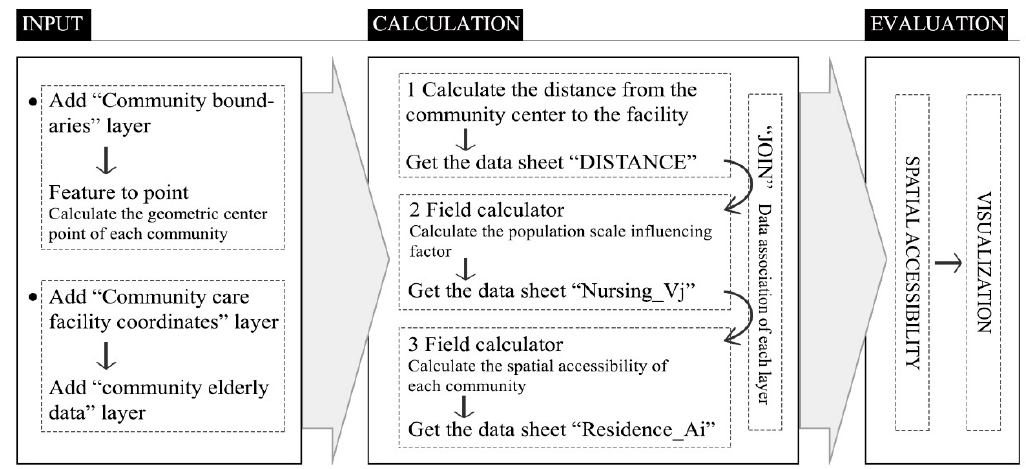
Figure 4. Implementation of the potential model in GIS.